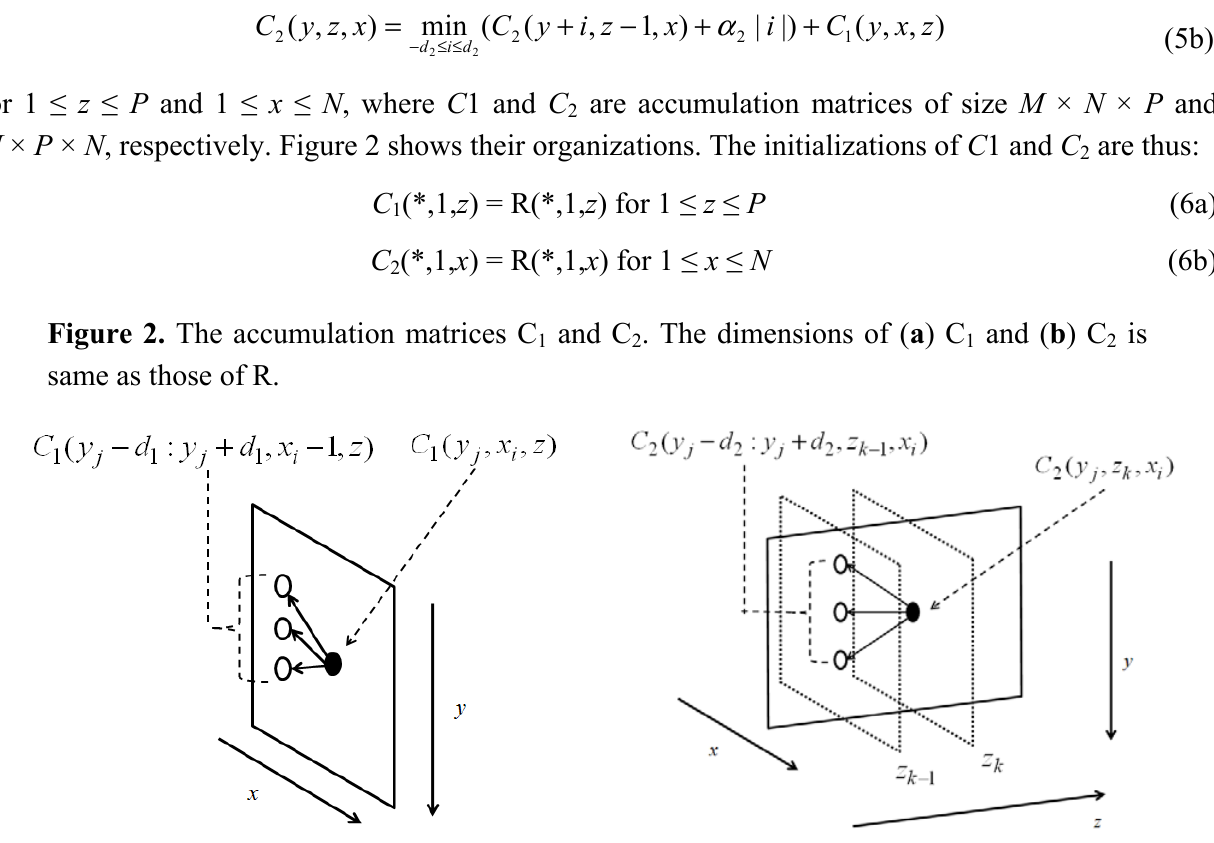
and C . The dimensions of ( a ) C 1 2